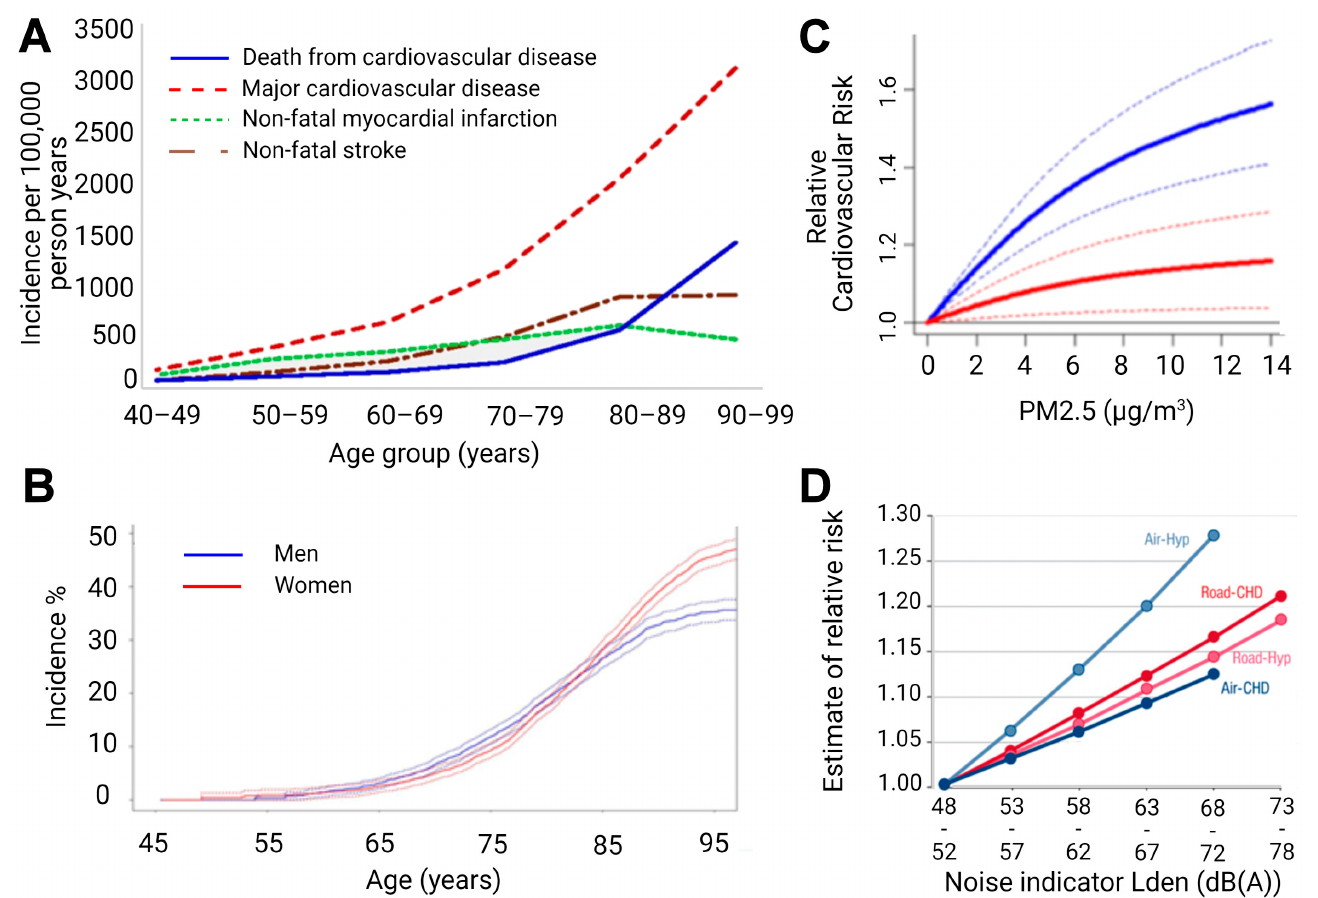
Figure 2. ( A ) Age-specific crude incidence of confirmed major cardiovascular disease by type of first event (non-fatal myocardial infarction, non-fatal stroke, and death from cardiovascular disease). Reused from [13] with permission under the terms of the Creative Commons Attribution Non-commercial License, Copyright © Driver et al. 2008. ( B ) Risk of common neurological diseases for 45-year-old men and women. In this analysis, follow-up ended at time of first occurrence of dementia, stroke, or parkinsonism. For instance, for individuals who first suffered a stroke and subsequently developed dementia, only the stroke event is considered. Reused from [14] with permission, Copyright © 2021, BMJ Publishing Group Ltd. All rights reserved. ( C ) Predicted values of relative risk for cardiovascular mortality by chronic exposure to increasing particulate matter concentrations for high ozone levels (37.60 ppb, solid blue line) and low ozone levels (20.26 ppb, solid red line) with uncertainty intervals (dashed lines). Reused from [15] with permission under the terms of the Creative Commons CC BY license, Copyright © 2021, The Author(s). ( D ) Exposure-response relationships for the associations between transportation noise and cardiovascular health outcomes. Road—road traffic noise, Air—aircraft noise, Hyp—hypertension, CHD—coronary heart disease, and Lden—day-evening-night level, i.e., the average sound pressure level measured over a 24-h period. Reused from [16] with permission, Copyright © 2021, Oxford University Press.